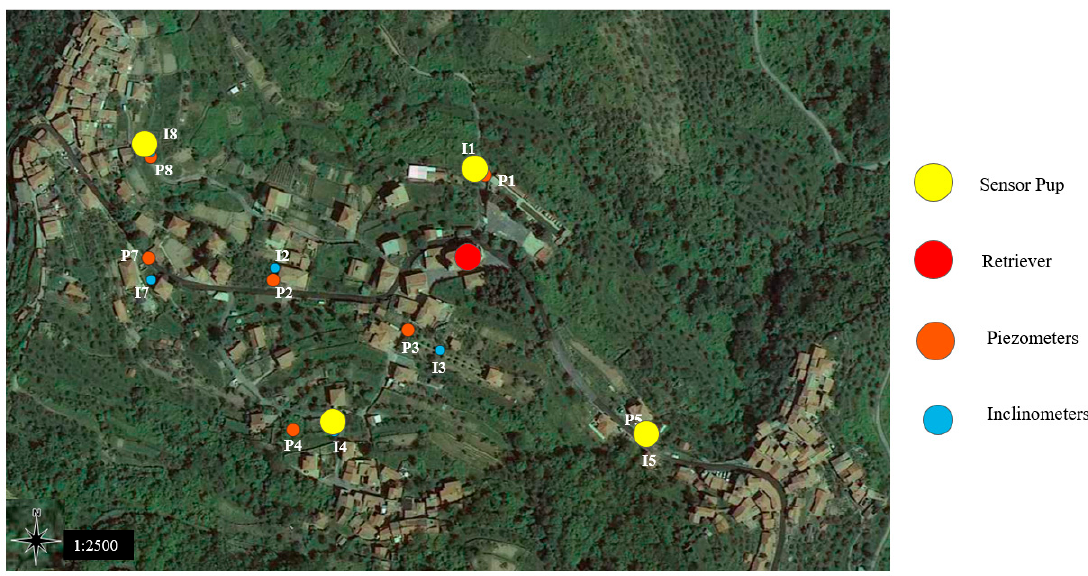
Figure 22. Monitoring network to be installed in Ville San Pietro.